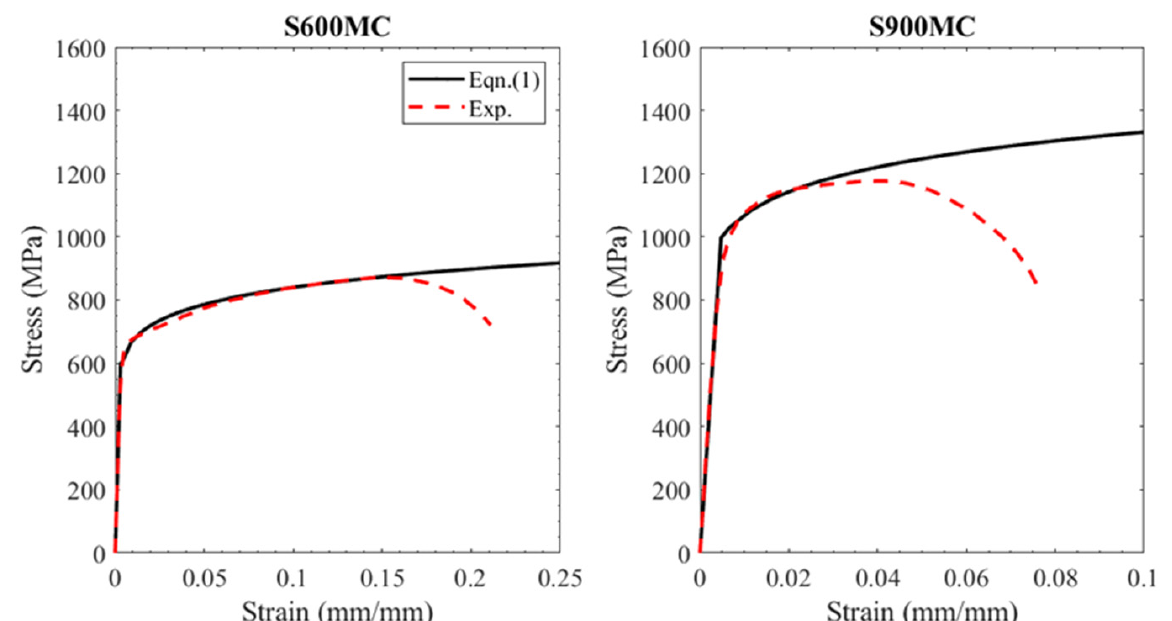
Figure 11. True stress–strain curves, with both the elasto-plastic model and the experimental values,